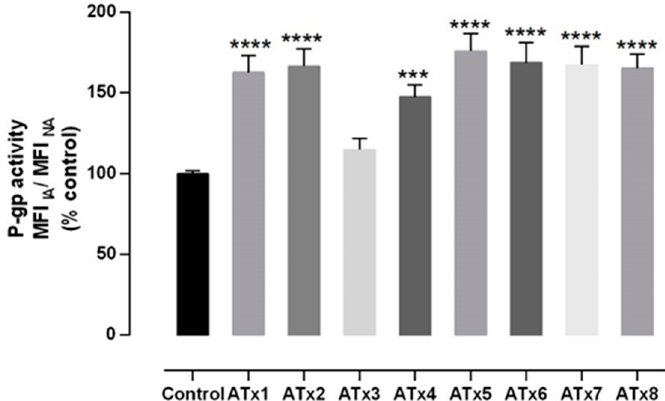
Figure 6. P-gp activity evaluated through the RHO 123 accumulation in Caco-2 cells exposed to chiral thioxanthones (20 µ M) for 24 h. Results are presented as mean ± SEM from four independent experiments (performed in duplicate). Statistical comparisons were estimated using One-way ANOVA, followed by Tukey’s multiple comparisons test (*** p < 0.001; **** p < 0.0001 vs. control (0 µ M)).